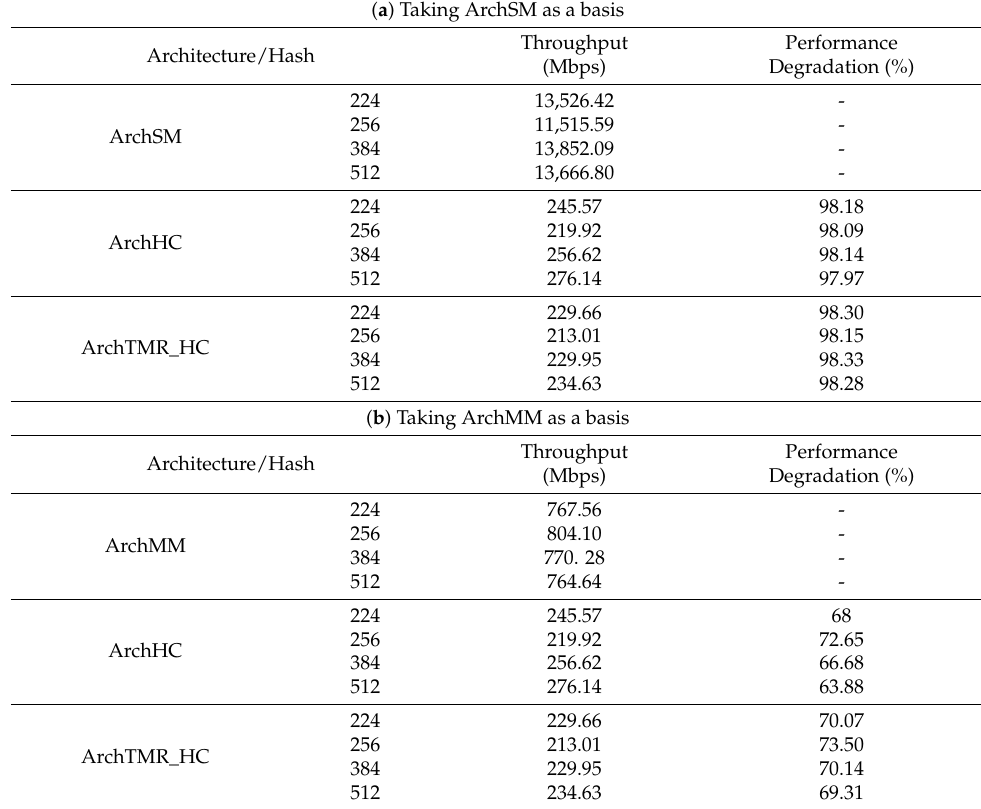
Table 6. Incremental